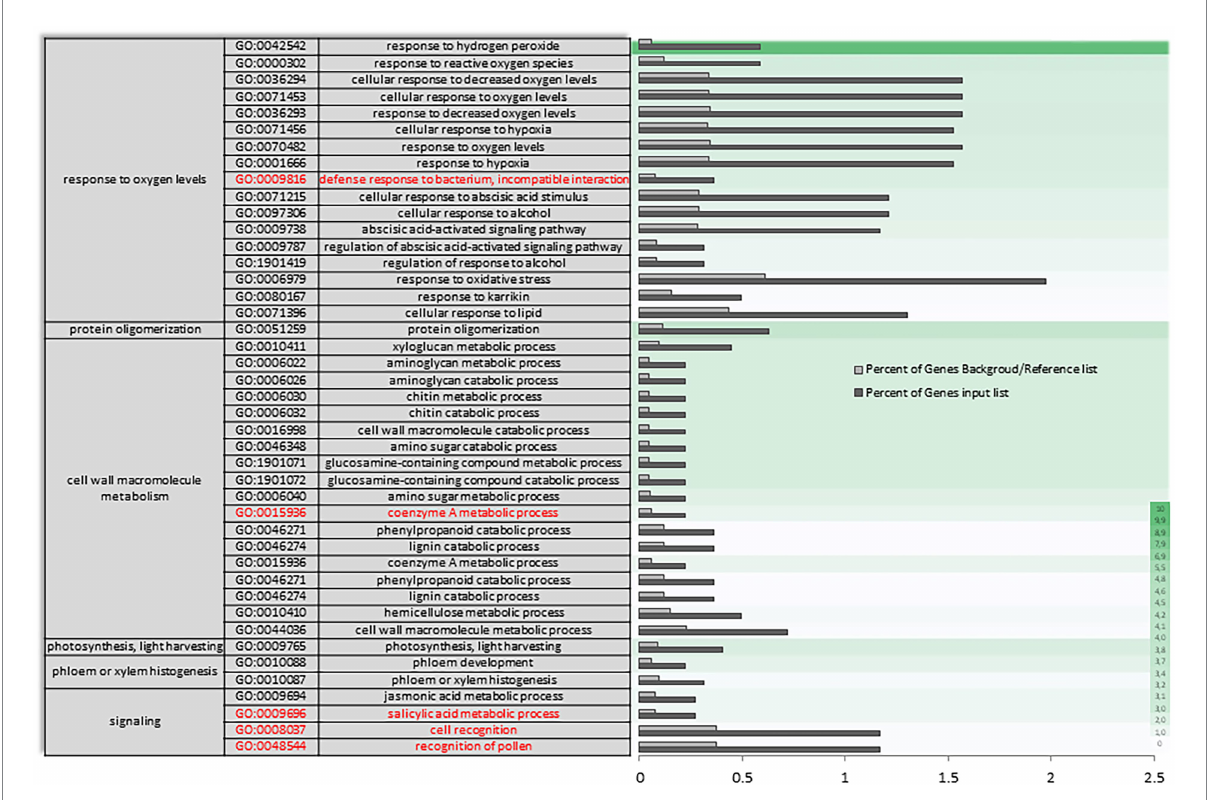
FIGURE 5 Specific gene ontology enrichment. DEGs obtained between after harvest (AH) and air-cold stored (ACS). Bar chart showing in detail the most significant biological processes terms overrepresented obtaining by a Singular Enrichment Analysis (SEA; FDR ≤ 0.05) in AH vs. ACS comparison. The Y -axis shows the definition of GO terms. The X -axis is the percentage of genes mapped by the term, and represents the abundance of the GO term. The percentage for the input list is calculated by the number of genes mapped to the GO term divided by the number of all genes in the input list. The same calculation was applied to the reference list to generate its percentage. These two bars are classificated by a color key showing a green gradient scale for the frequency between both percentages